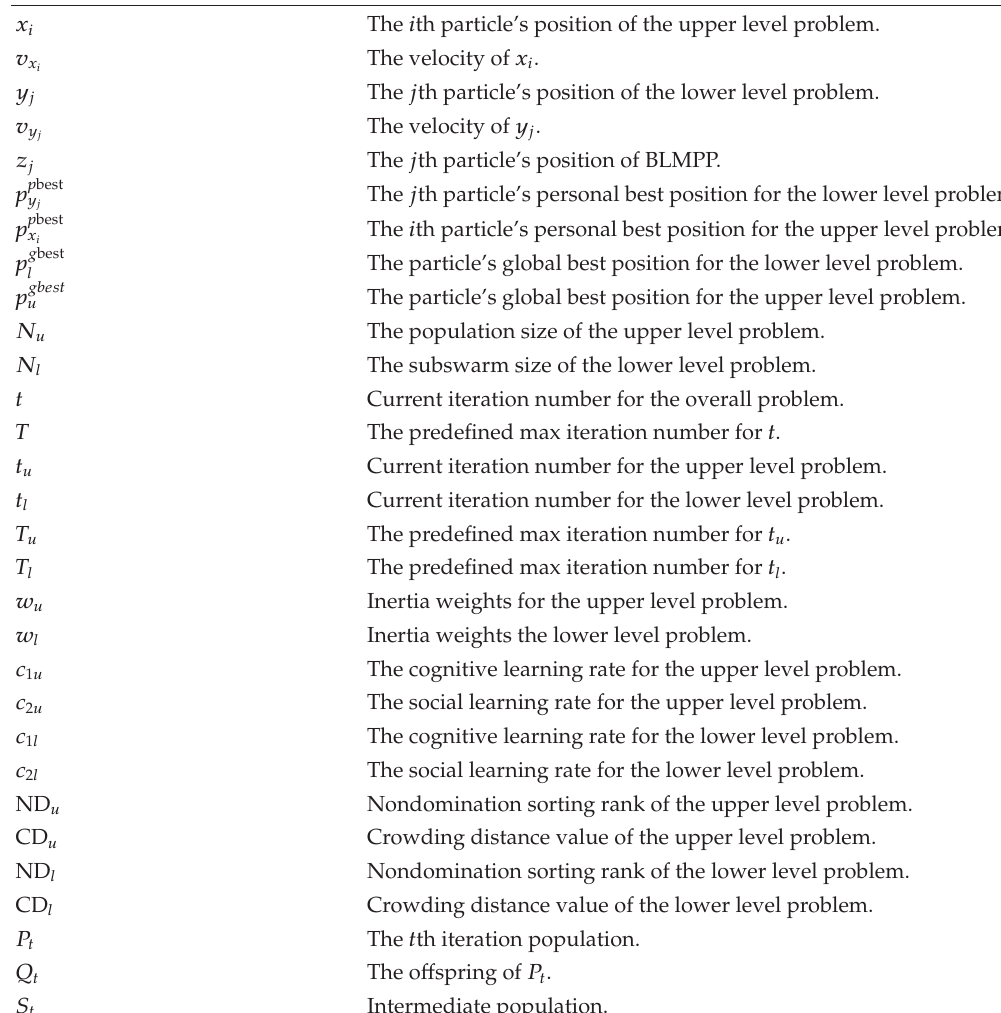
Table 1: The notations of the